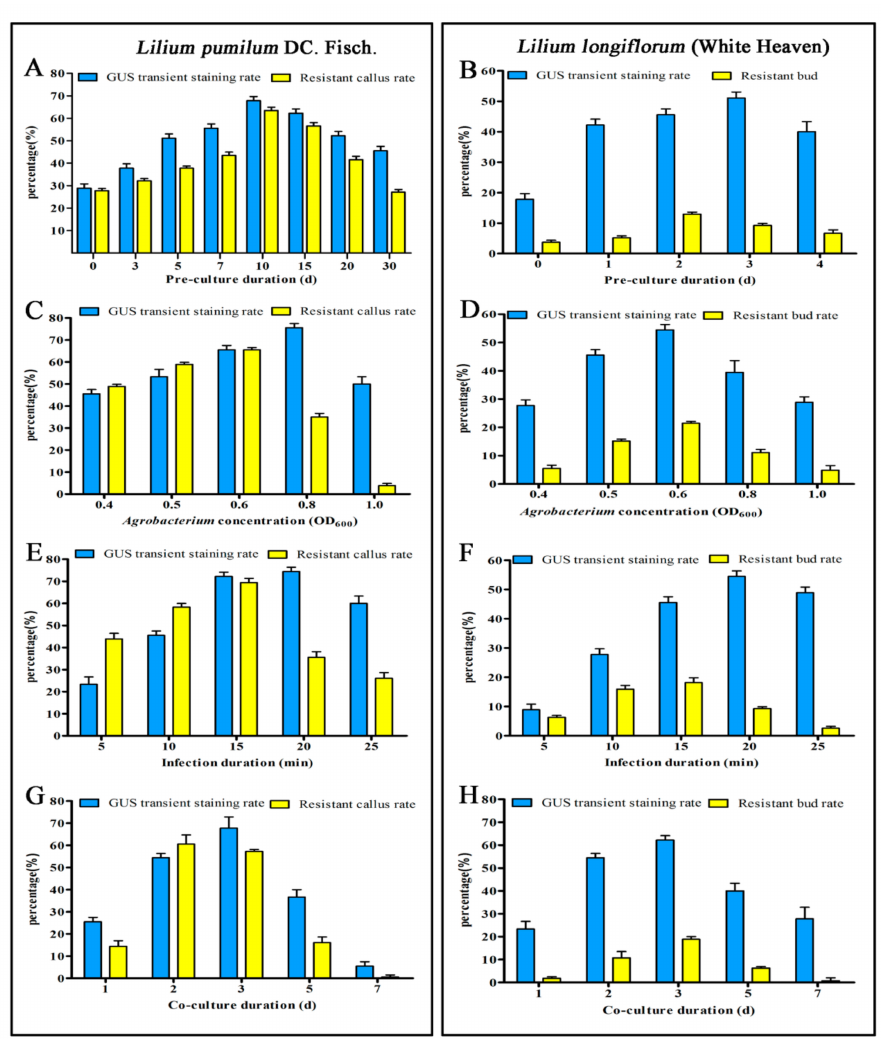
Figure 1. Parameters a ff ecting transformation e ffi ciency. A and B E ff ects of pre-culture duration on transformation e ffi ciency. C and D E ff ects of Agrobacterium concentration on transformation e ffi ciency. E and F E ff ects of infection duration on transformation e ffi ciency. G and H E ff ects of co-culture duration on transformation e ffi ciency. Left results for Lilium pumilum DC. Fisch.; right results for ‘White Heaven’. All data are expressed as means ± standard deviation of triplicate samples. d: